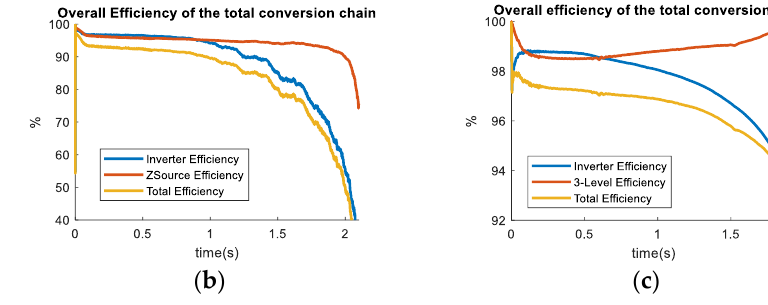
Figure 22. Overall efficiency of the powertrain conversion of ( a ) the two paralleled ST IGBT BqZSI topology, ( b ) single ST IGBT BqZSI topology, and ( c ) 3-level DC-DC/SVPWM. The voltage and the current in the 3-level converter are highly controlled values (a).